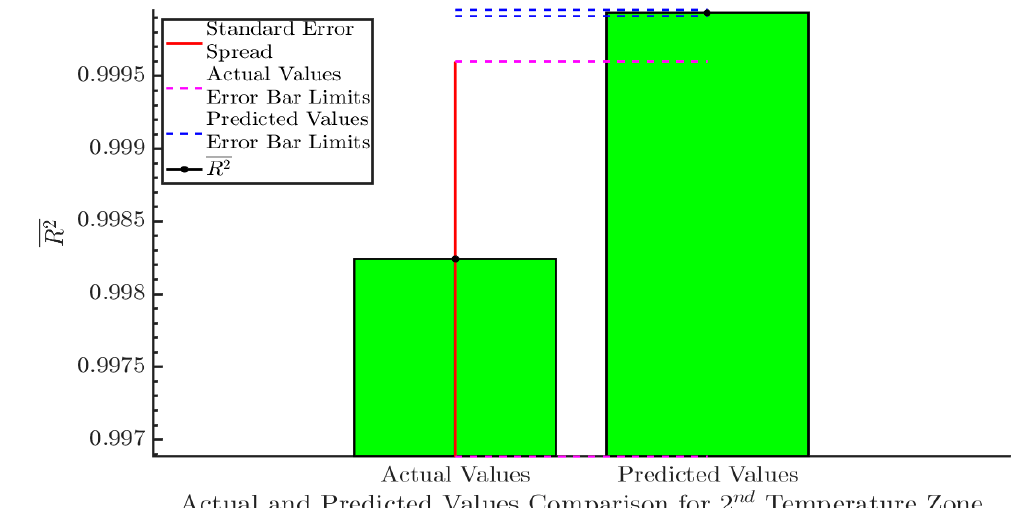
Figure 6. Comparison between actual and predicted values for the 2nd temperature zone. This diagram compares the R 2 for the actual and predicted values. The 95% CI for each category can be seen with a red vertical line. The limits for each CI are depicted with magenta (actual values), and blue (predicted values) dashed lines. The two Cis do not overlap, which is a strong indication that the error reduction achieved after the application of linear regression is statistically significant.